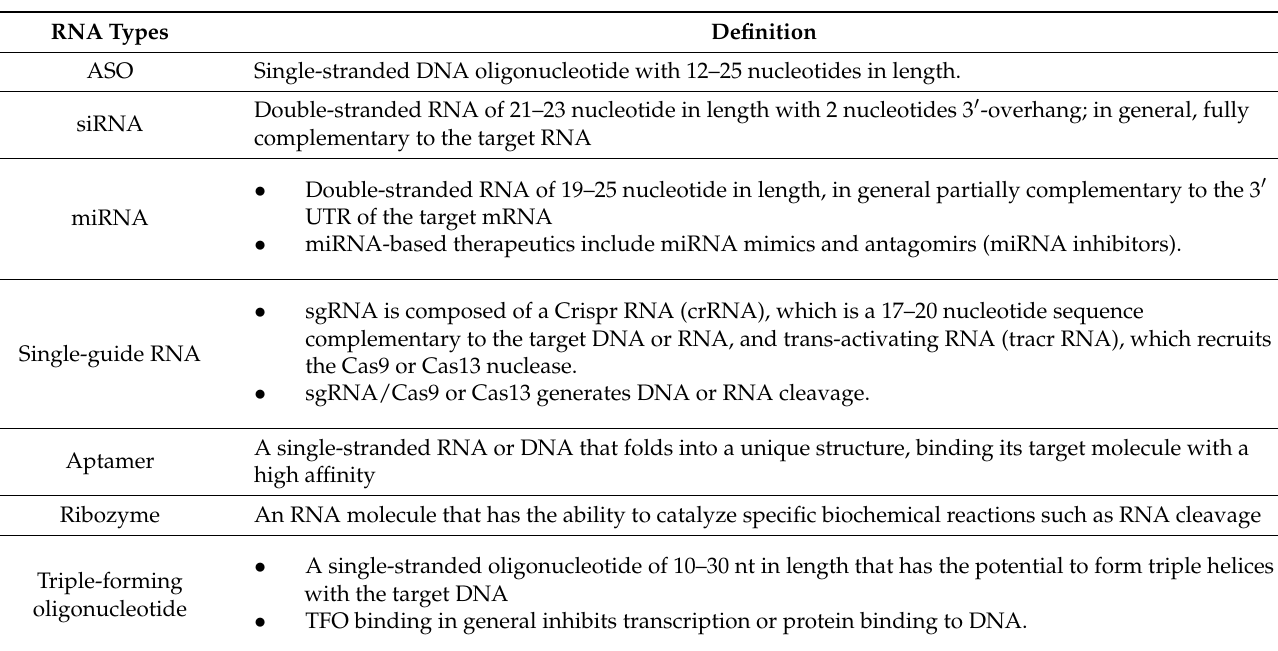
Table 1. Therapeutic RNAs